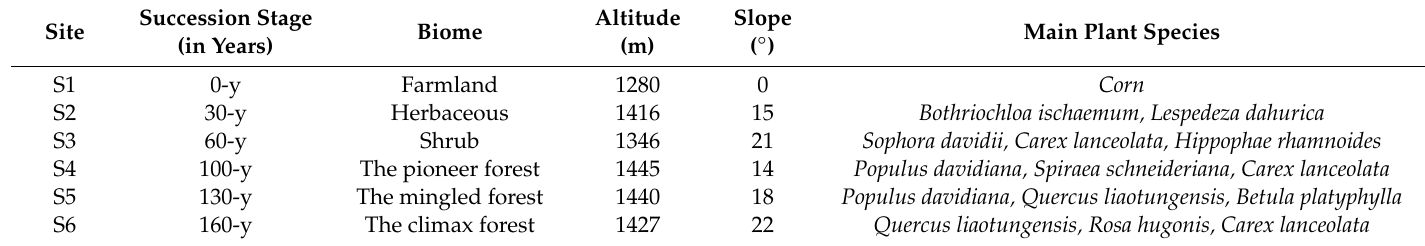
Table 1. Geographical and vegetation characteristics at di ff erent stages of restoration in the Ziwuling forest region of the Loess Plateau,